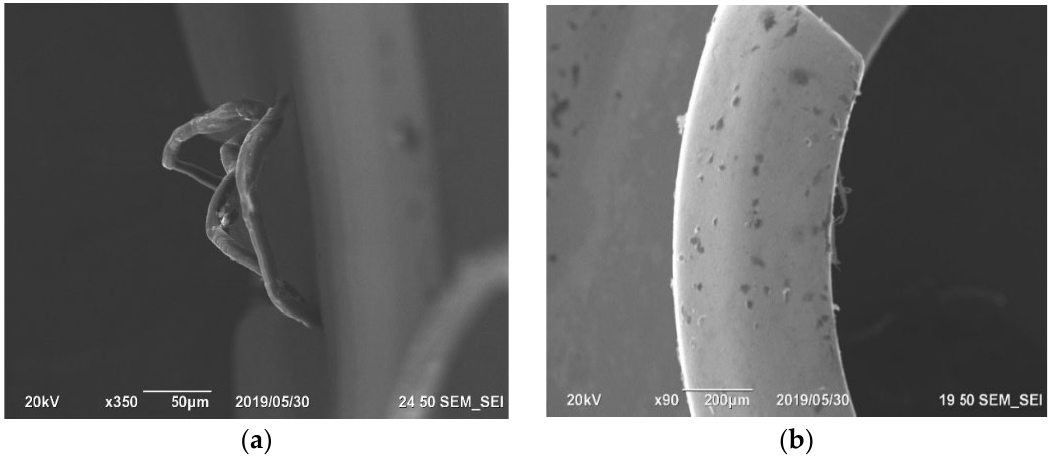
Figure 2. Change in the nature of burrs on parts made of beryllium bronze: ( a ) processing with the parameters recommended by the tool manufacturer (upper values); ( b ) processing the experimentally selected